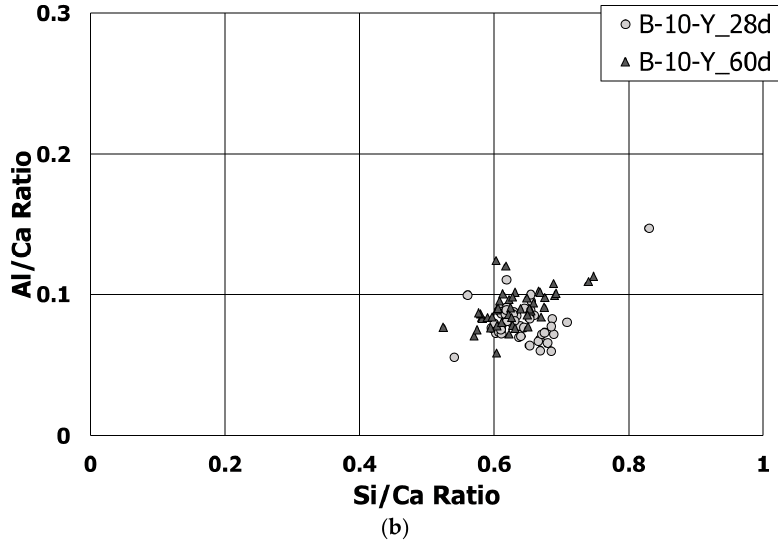
Figure 10. The Al/Ca vs. Si/Ca ratios for Mixtures ( a ) B-0-N and B-0-Y; and ( b ) B-10-Y at different ages.